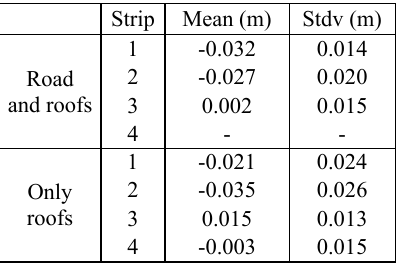
Table 4. Statistic of signed cloud-to-mesh distances to flight strip five